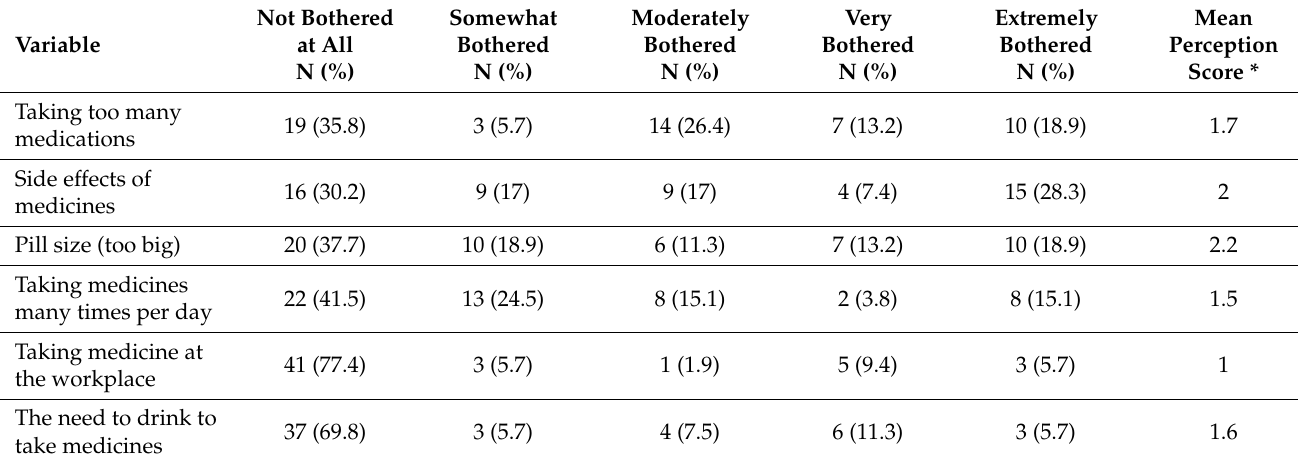
Table 2. Participant responses to the Perceived Burden of Therapy (PBOT) Survey.